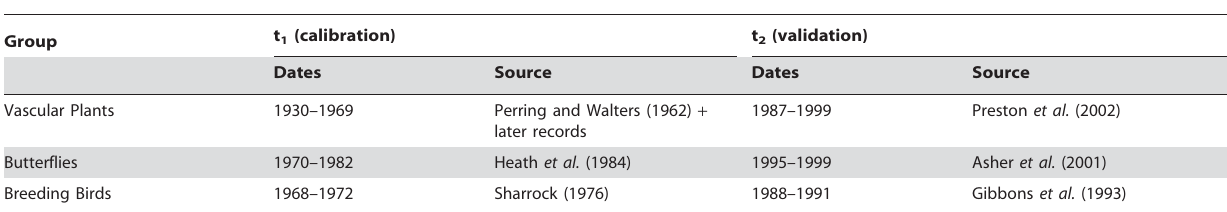
Table 1. Dates and sources of the distribution records